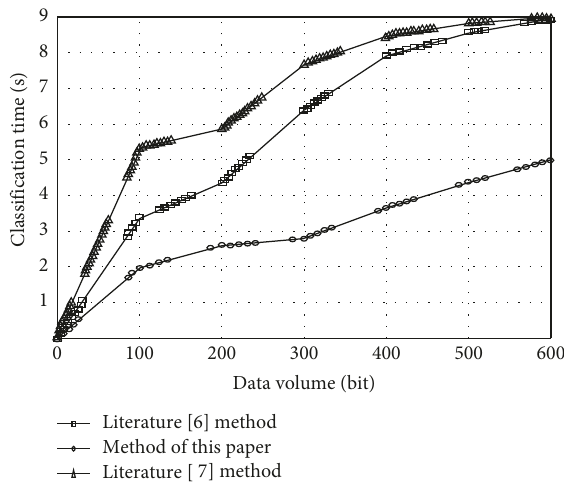
Figure 2: Comparison results of classification time of the three